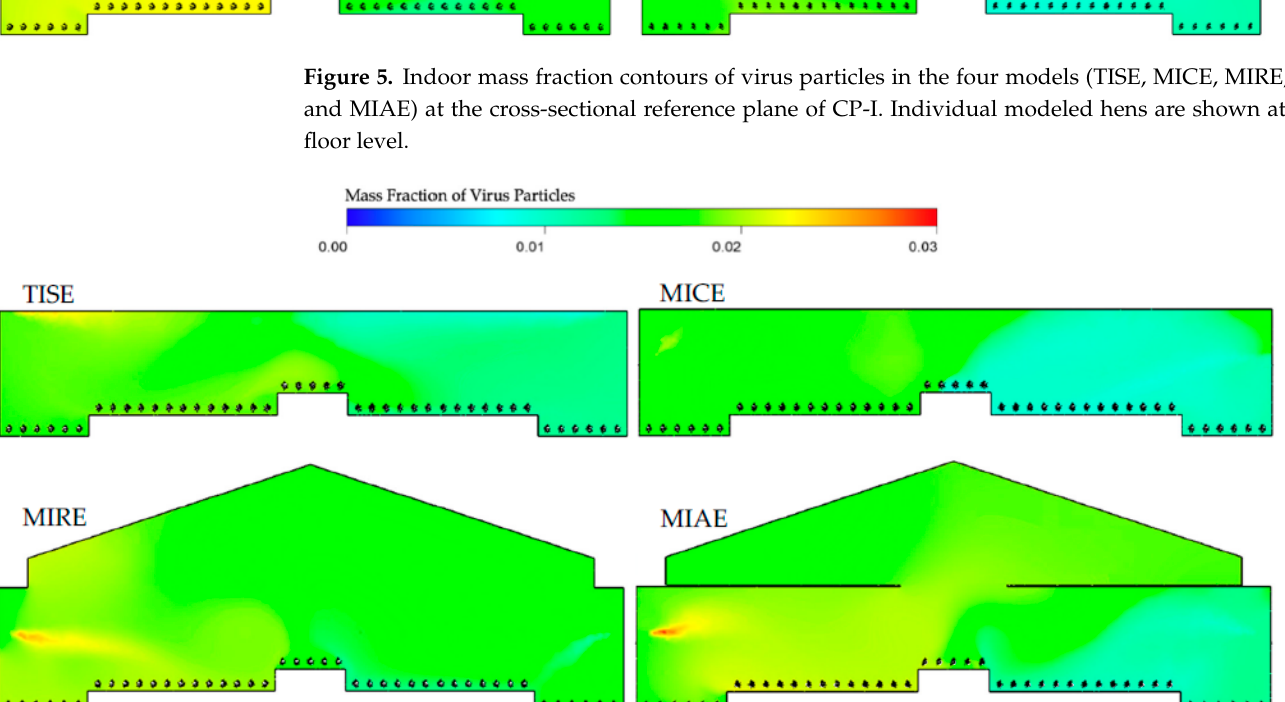
Figure 6. Indoor mass fraction contours of virus particles in the four models (TISE, MICE, MIRE, and MIAE) at the cross-sectional reference plane, CP-N.